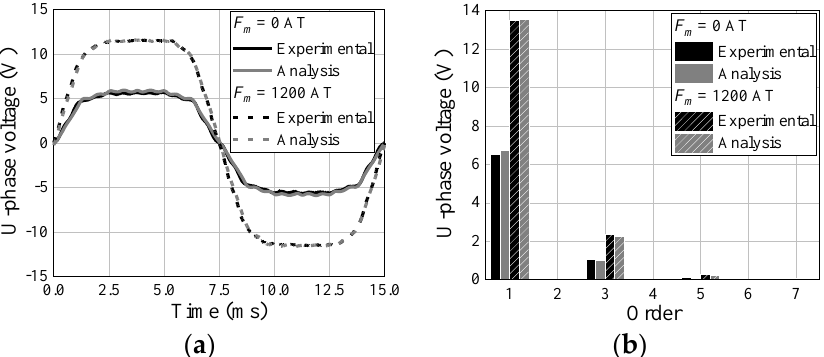
Figure 14. U-phase back e.m.f. at rotating speed of 1000 r/min: ( a ) waveforms; ( b ) FFT results.